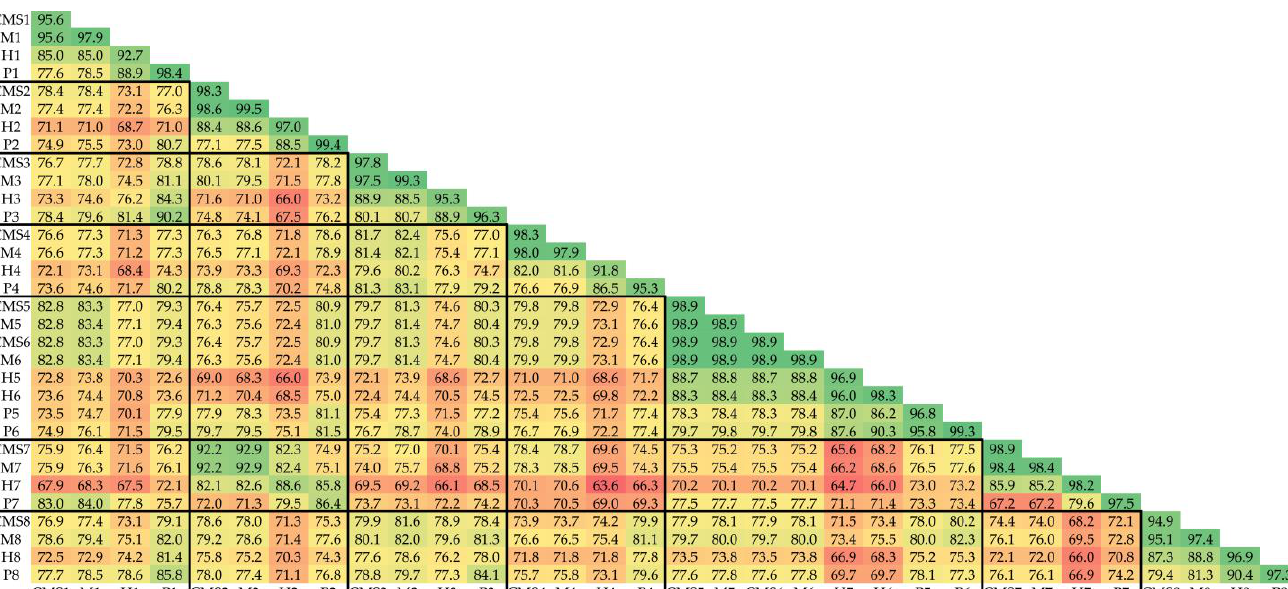
Table 4. Descriptive statistics for all SSR loci for CMS-M groups. The number of individuals (N), number (n pl ) of polymorphic loci, percentage (% pl ) of polymorphic loci, mean number of observed (n a ) alleles per locus, mean number of effective (n e ) alleles per locus, total (H T ) genetic variability, within (H S ) genetic variability, observed (H o ) homozygosity, expected (H e ) homozygosity, Rohlf’s simple matching genetic similarity (GS) coefficient and gene flow estimates (Nm). The mean values within population (Mean CMS-M) and the mean values calculated considering all the possible pairwise comparisons among the CMS-M groups were estimated. Population ID